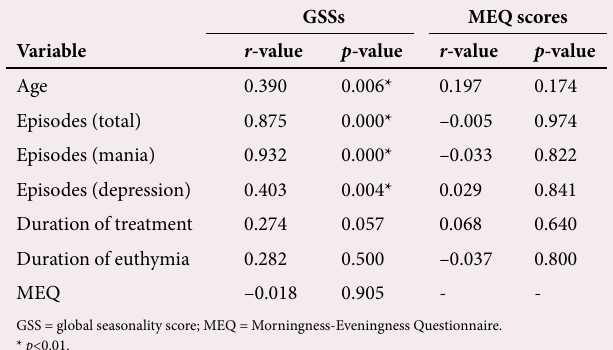
Table 1. Correlation of clinical